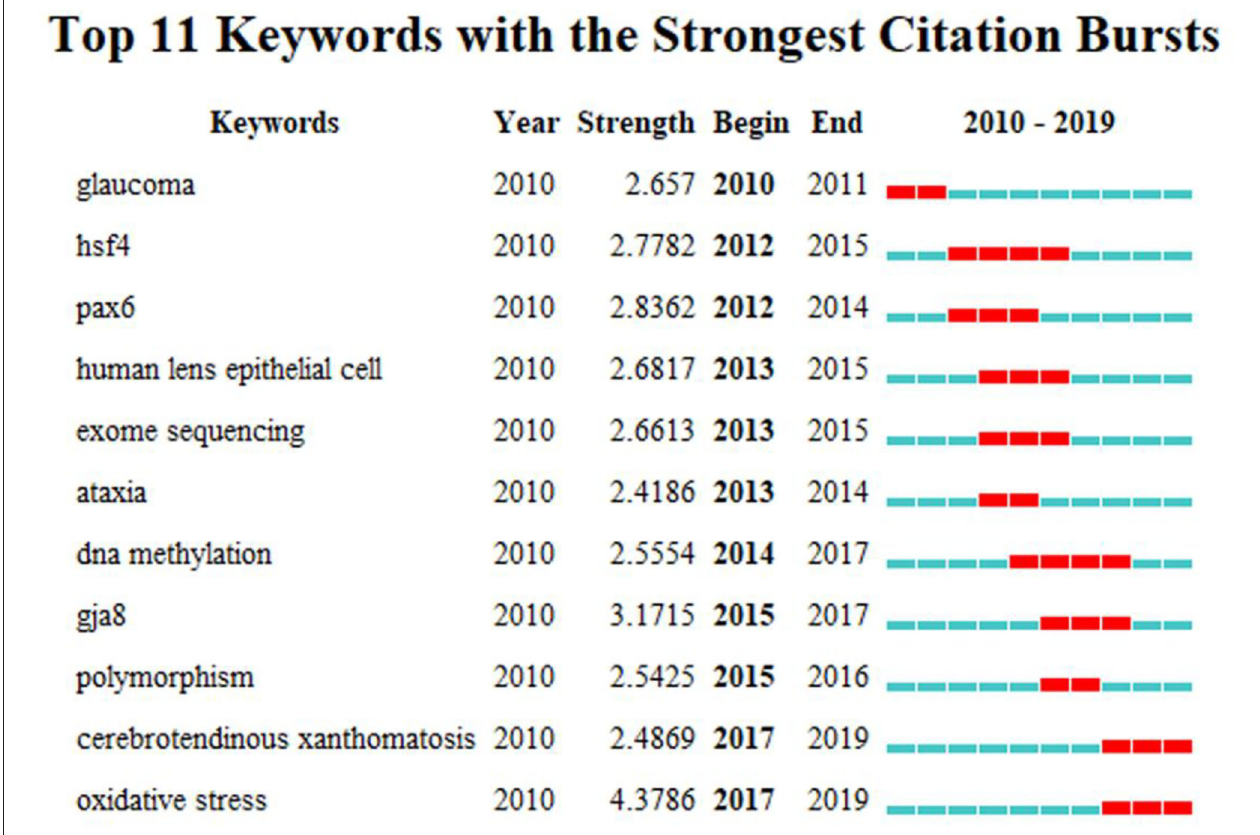
FIGURE 9 | The keywords with The strongest citation bursts of publications on Cataract-gene from 2010 to 2019.